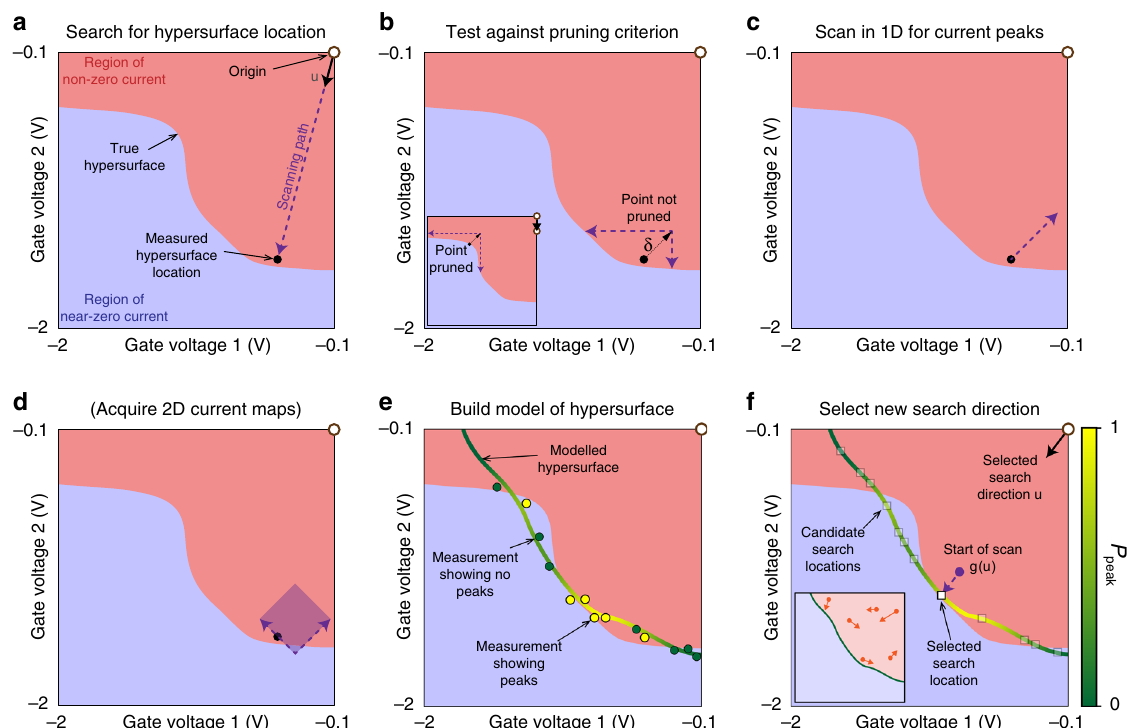
Fig. 4 Characterising the boundary hypersurface using machine learning. Each panel illustrates a step of the algorithm presented in Fig. 3. The gate voltage space, restricted to two dimensions for illustration, is divided into regions of near-zero (blue) and non-zero current (pink), separated by a boundary hypersurface. a Locating the hypersurface. The gate voltages are scanned along a ray (violet arrow) starting at the origin (white circle) and de fi ned by direction u . By monitoring the current, the intersection with the hypersurface is measured. b To determine whether a region should be pruned, the algorithm scans each gate voltage individually toward the bottom of its range from a location just inside the hypersurface as shown. If only one scan intersects the hypersurface (as in the inset), future exploration of that region is inhibited by displacing the origin as shown. c Based on a short 1D scan, the location is classi fi ed according to whether it shows current peaks indicating Coulomb blockade. d If peaks are found, a 2D scan (violet square) is performed in the plane of V 3 and V 7 , and is possibly repeated at higher resolution. e From the fi rst thirty measurements (green and yellow circles), the algorithm builds a model of the hypersurface and assigns a probability ~ P peak that peaks will be found. f To re fi ne the model, the algorithm generates a set of candidate search locations (squares), each weighted by its corresponding value of ~ P peak , and selects one at random. A new scan is then performed in the corresponding direction to generate a new measurement of the hypersurface location. Steps d – f are then repeated inde fi nitely. Inset: Scheme for numerically sampling the hypersurface using simulated Brownian motion. Each point represents a simulated particle moving inside the enclosed volume. The collisions between the particles and the modelled hypersurface generate a set of candidate search